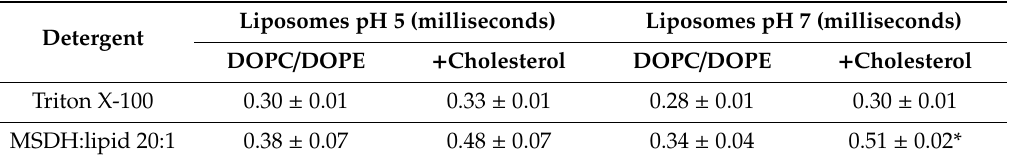
Figure 2. Fluorescence correlation spectroscopy (FCS) analysis of MSDH-induced leakage of large molecules from liposomes. Dextran–rhodamine (TRITC-dextran) (40 kDa) was encapsulated in liposomes containing 40% or no cholesterol. Liposomes were mixed with increasing concentrations of MSDH and leakage was analyzed using fluorescence correlation spectroscopy (FCS). Triton X-100 was used to completely disintegrate the liposomes. Normalized autocorrelation data from FCS measurements in ( A ) liposomes at pH 7 prepared without or ( B ) containing 40% cholesterol. ( C ) Liposomes at pH 5 prepared without or ( D ) containing 40% cholesterol. Each curve is the average of > 3 measurements of 20 s each. Table 1. FCS decay times of TRITC-dextran 40 encapsulated liposomes.